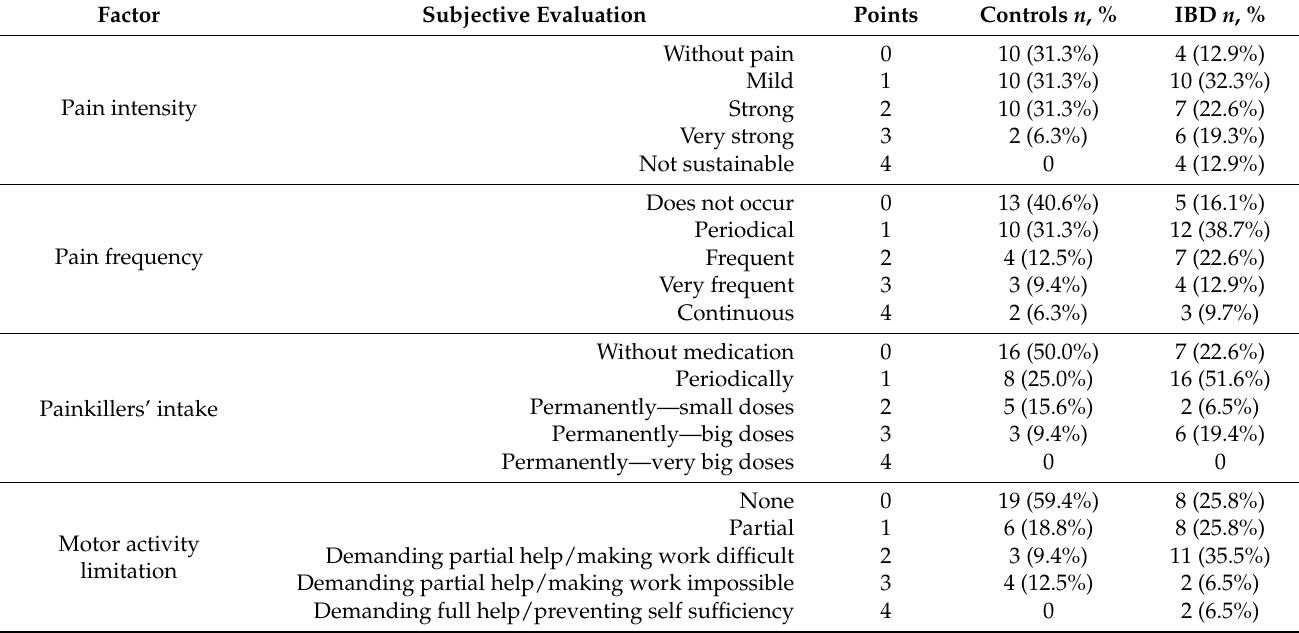
Table 3. Laitinen Pain Scale’s results in enrolled IBD patients and